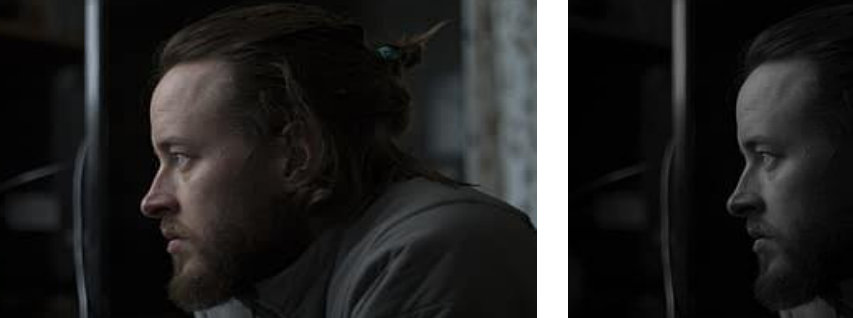
lighting condition.